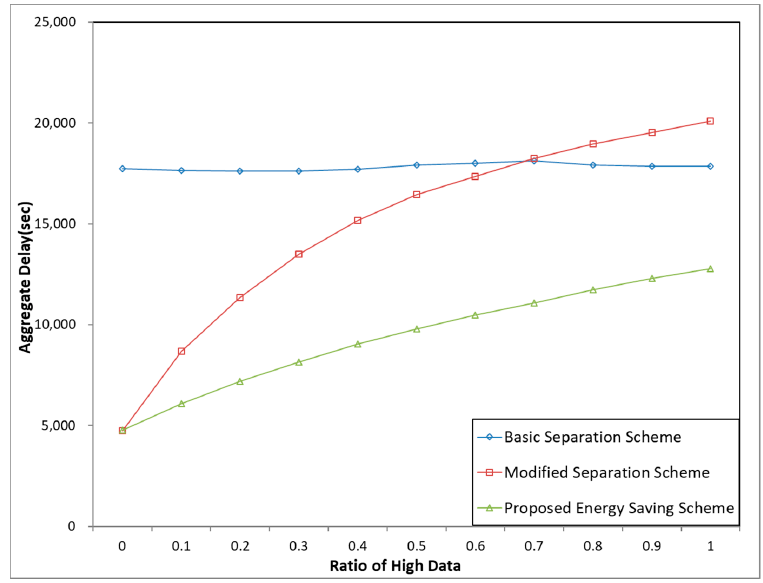
Figure 16. Aggregate delay.